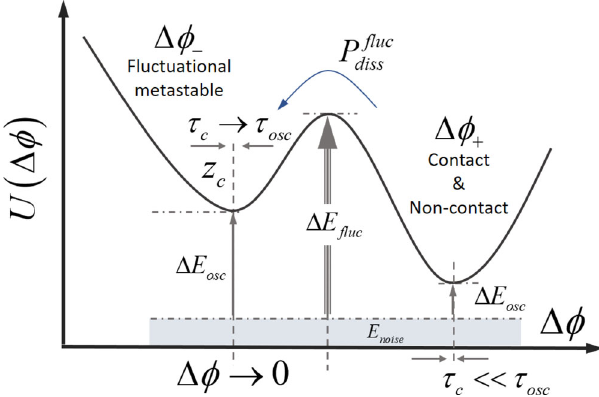
(cid:9) (cid:10) for the generalized theoretical